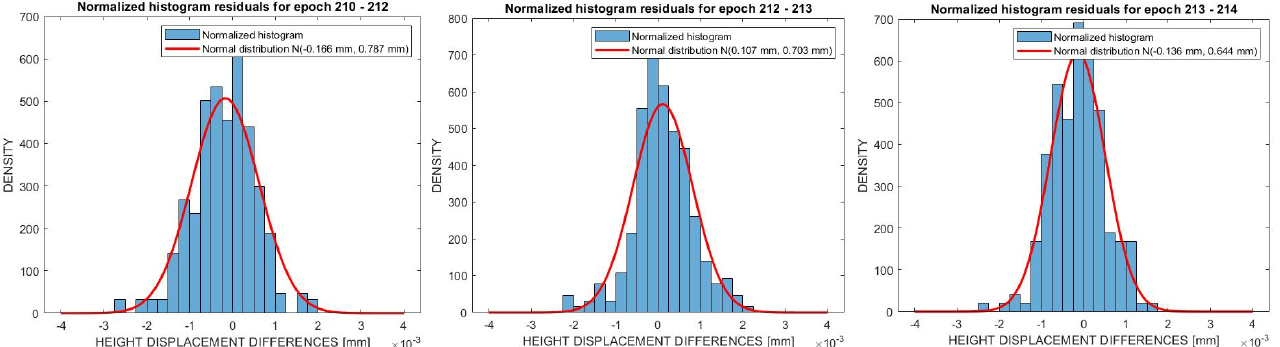
Figure 15. Normalized histograms and distribution of residuals for epochs for BEAM 1. (Source: Own compilation).